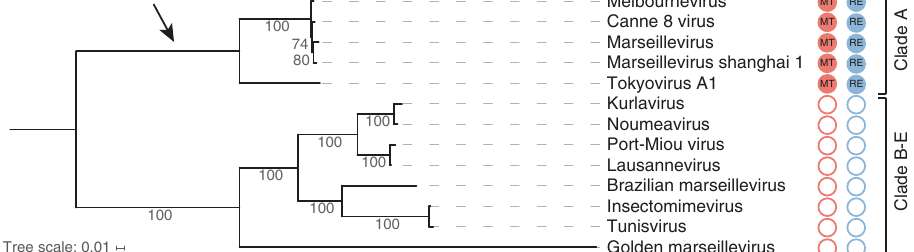
Fig. 2 Presence/absence of R-M systems in the Marseilleviridae family. Phylogeny of the Marseilleviridae completely sequenced viruses with the following GenBank accessions: melbournevirus (KM275475.1) 37 , cannes 8 virus (KF261120.1) 88 , marseillevirus (GU071086.1) 89 , marseillevirus shanghai 1 (MG827395.1), tokyovirus A1 (AP017398.1) 90 , kurlavirus (KY073338.1) 91 , noumeavirus (KX066233.1) 43 , port-Miou virus (KT428292.1) 92 , lausannevirus (HQ113105.1) 48 , brazilian marseillevirus (KT752522.1) 93 , insectomimevirus (KF527888.1) 94 , tunisvirus (KF483846.1) 95 and golden marseillevirus (KT835053.1) 96 . The phylogeny was based on protein sequence alignments of the 115 strictly conserved single copy orthologues (see Supplementary Data 1). The tree was calculated using the best model of each partitioned alignment as determined by IQtree 82 . Bootstrap values were computed using the UFBoot 84 method. The red and blue fi lled circles highlight the presence of encoded marseilleviruses R-M systems MTases and REases respectively. The empty circles highlight the absence of the MTase (in red) and the REase (in blue). The arrow points to the most parsimonious acquisition of a R-M system in the Marseilleviridae